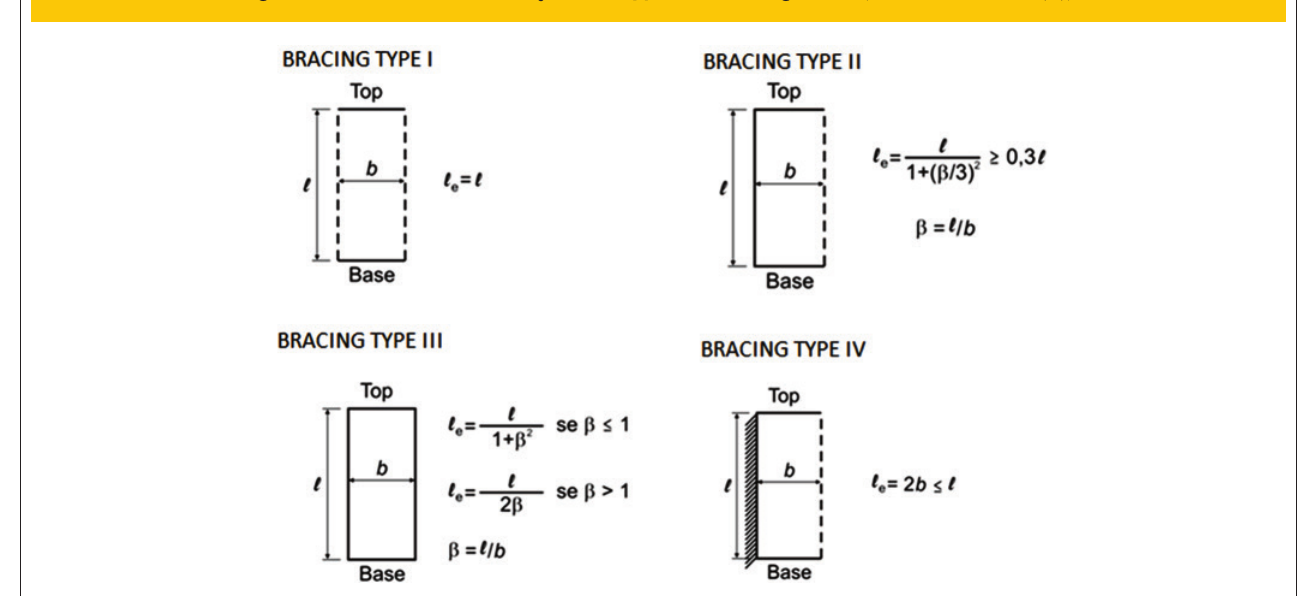
Figure 18 – Calculation of ℓ as the type of bracing walls (NBR 16055:2012 [4])